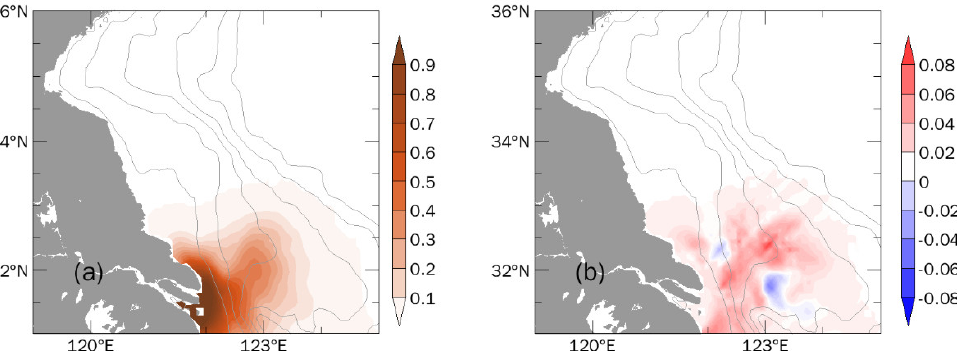
Figure 6. Simulated distribution of the passive tracer ( a ) in Exp.C and ( b ) anomaly distribution in Exp.R at the sea surface in late April with the bathymetry.